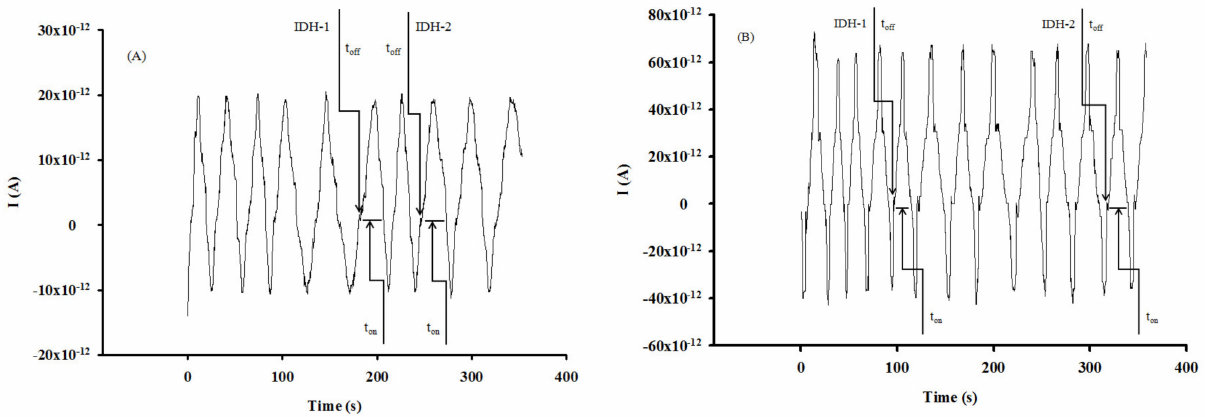
Figure 4. Examples of diagrams recorded for the molecular recognition of IDH1 and IDH2 in brain tumor tissue samples using the stochastic microsensors based on ( A ) CuAuNP-PIX-SWCNT and ( B ) CuAuNP-PIX-MWCNT.